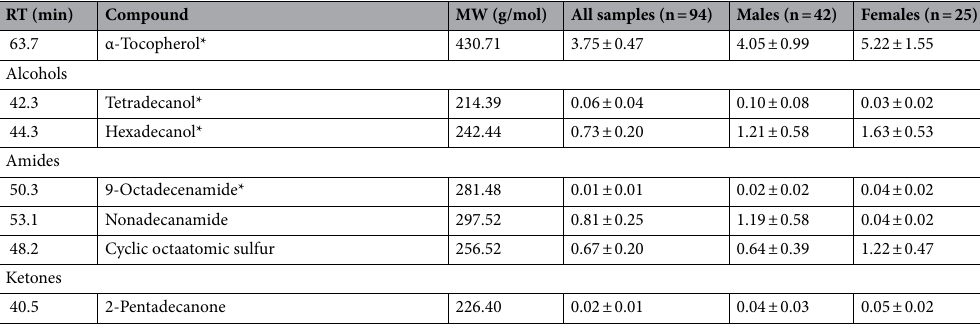
(15.6%) and carboxylic acids and their esters (13.3%). The five most abundant compounds in feces of males were indole (28.1%), cholesterol (12.9%), hexadecanoic acid (6.5%), cholest-4-en-3-one (5.7%) and phenol (5.1%), whereas the main compounds in feces of females were indole (36.5%), squalene (8.0%), cholesterol (6.8%), phe- nol (5.1%), and α-tocopherol (5.2%) (Table 1). The PERMANOVA analysis based on the resemblance matrix comparing samples of each sex showed sig- nificant differences in the overall proportion of compounds in the entire chemical profile between males and females (pseudo F 1,65 = 5.69, P = 0.02). Also, results from the PCA showed that there were significant intersexual differences in the compounds described by PC4 (ANOVA, F 1,65 = 11.14, P = 0.014; Fig. 1), but not in the other PCs (ANOVA, at least P > 0.15 in all cases). Thus, according to the significant correlations of the compounds with the PCs, males had higher levels of steroids such as cholesterol and cholesta-4-en-3-one than females (Table 1). Moreover, a discriminant analysis based on these compounds described by PC4 alone assigned correctly the sex of 79% of feces of males and 31% of feces of females (Wilks’ λ = 0.85, F 1,65 = 11.30, P = 0.013). Seasonal differences. The PERMANOVA analysis based on the resemblance matrix comparing samples of each season showed that there were significant differences in the overall proportion of compounds among the three seasons (pseudo F 2,91 = 1.58, P = 0.037). However, pairwise permutational post-hoc tests showed that there were significant differences between the reproductive and the non-reproductive season (P = 0.01) and between the reproductive and the breeding seasons (P = 0.039), but there were not significant differences between the breeding and the non-reproductive seasons (P = 0.51). The CAP analysis assigned 49% of the chemical profiles into the correct season using Euclidean distances between samples (permutational test, δ 1 2 = 0.49, P = 0.043, using leave-one-out cross-validation and m = 30 axis). A further two-way PERMANOVA restricted to samples that could be sexed (n = 67) confirmed that there were significant overall seasonal differences and significant differences between sexes independently of the seasonal variation (season: pseudo F 2,61 = 2.15, P = 0.002; sex: pseudo F 1,61 = 1.89, P = 0.027; season × sex: pseudo F 2,61 = 0.78, P = 0.79). The analysis of seasonal variation in the PCs resulting from the PCA of compounds showed that there were significant seasonal differences in the compounds described by PC4 (ANOVA, F 2,91 = 4.28, P = 0.017) and by PC3 (ANOVA, F proportions of hexanal and several fatty acids (PC3) and of cholesterol and α-tocopherol (PC-4) than during the non-reproductive (Tukey’s tests, P = 0.02 for both PCs) and the breeding seasons (P < 0.05 for both PCs) (Table 3). These two seasons did not differ significantly between them (P > 0.78 for both PCs). A discriminant analysis based on compounds described by PC3 and PC4 alone classified samples into the correct season for 44% of samples of the reproductive period and 92% of samples of the non-reproductive and breeding seasons (Wilks’ λ = 0.82, F 4,180 = 4.54, P = 0.0016). Marking function of feces. The PERMANOVA analysis based on the resemblance matrix comparing sam- ples of feces deposited with a presumably marking function (i.e., feces left on conspicuous substrates, above ground level, at crossroads and/or remarking other feces) with those of feces with a non-marking function (i.e., feces that were on inconspicuous substrates and/or at ground level, off crossroads, non-remarking) showed that there were not significant differences in the overall proportion of compounds between feces with different functions (pseudo F 1,90 = 0.74, P = 0.79). Nevertheless, the PCA showed significant differences in the compounds described by the PC4 (ANOVA, F 1,90 = 8.03, P = 0.006; Fig. 3), but not in the other PCs (P > 0.12 for all), suggest- ing that feces with a presumably marking function had higher proportions of α-tocopherol and cholesterol than